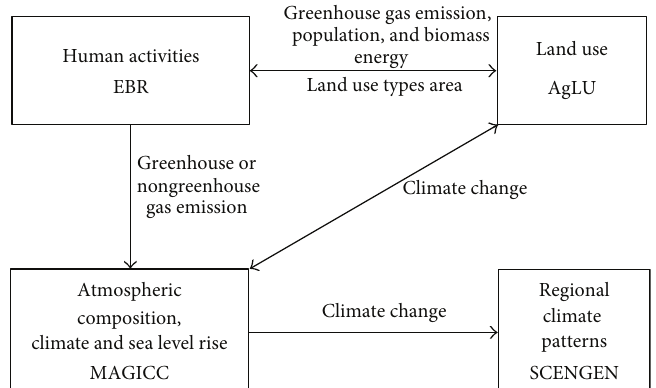
Figure 1: The framework of GCAM